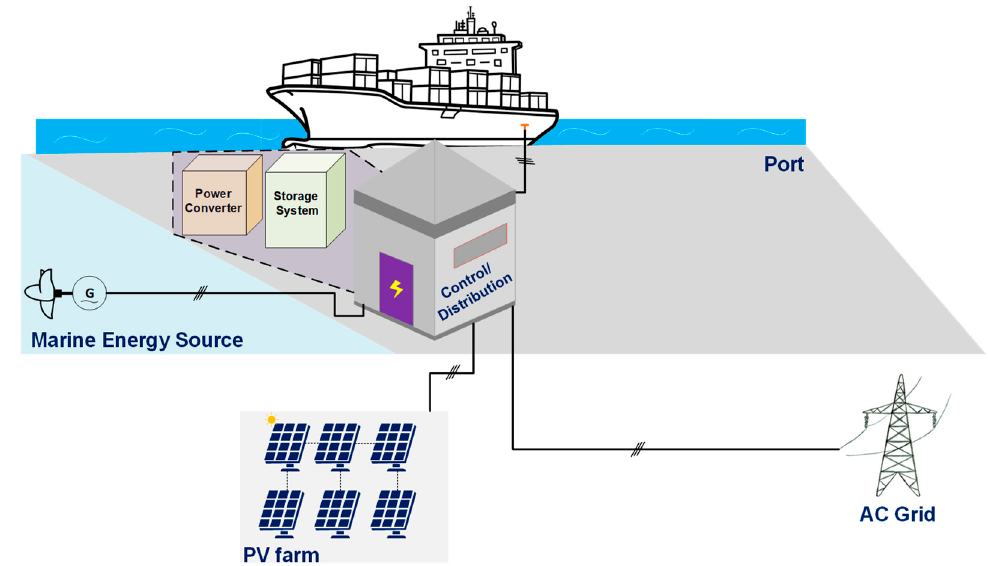
Figure 1. The proposed shore-power energy conversion